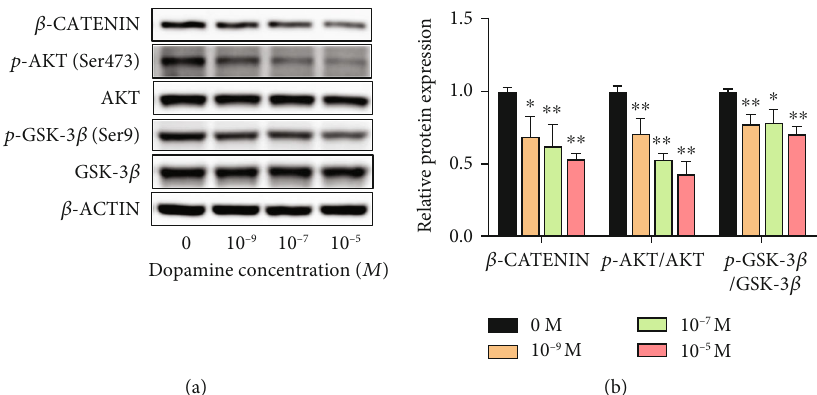
Figure 4: DA suppresses AKT/GSK-3 β / β -catenin signaling pathway during osteogenic di ff erentiation of rBMSCs. (a) Expression levels of AKT, p-AKT, GSK-3 β , p-GSK-3 β , and β -CATENIN analyzed by western blot assay after 24 h of di ff erentiation. (b) Quanti fi cation of p- AKT/AKT ratio, p-GSK-3 β /GSK-3 β ratio, and β -catenin. ∗ p < 0 : 05 and ∗∗ p < 0 : 01